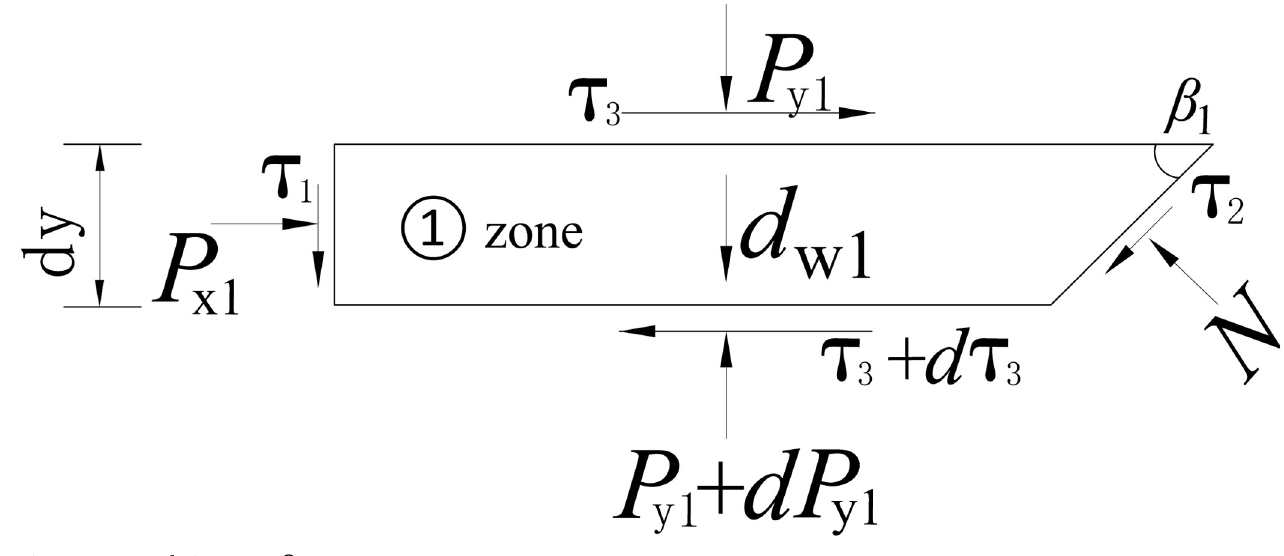
The static equation is obtained considering the horizontal static equilibrium condition.